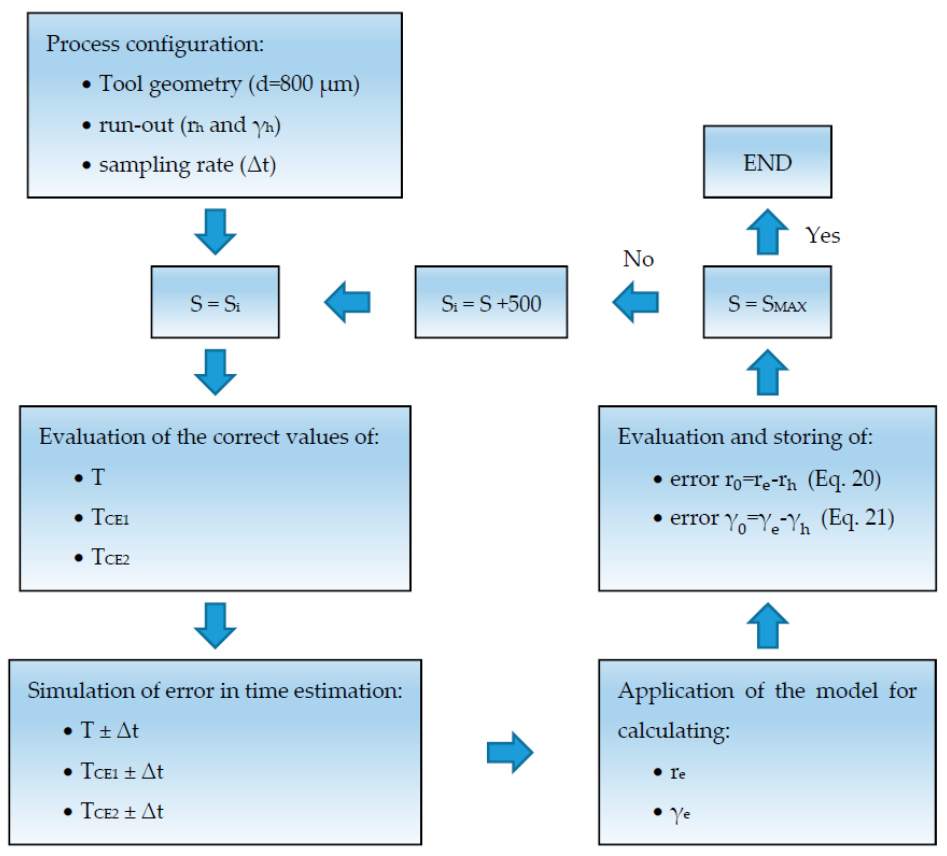
Figure 6. Flow chart of the sensitivity analysis of spindle speed influence on procedure accuracy.